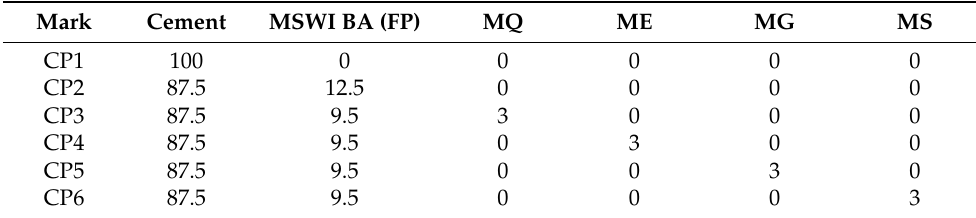
Table 3. Compositions of cement pastes (%) by